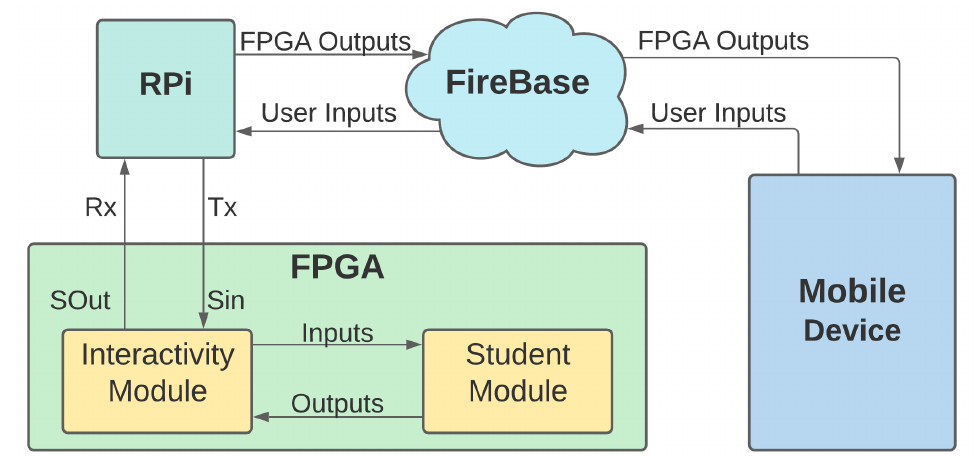
Figure 2. The remote access FPGA system